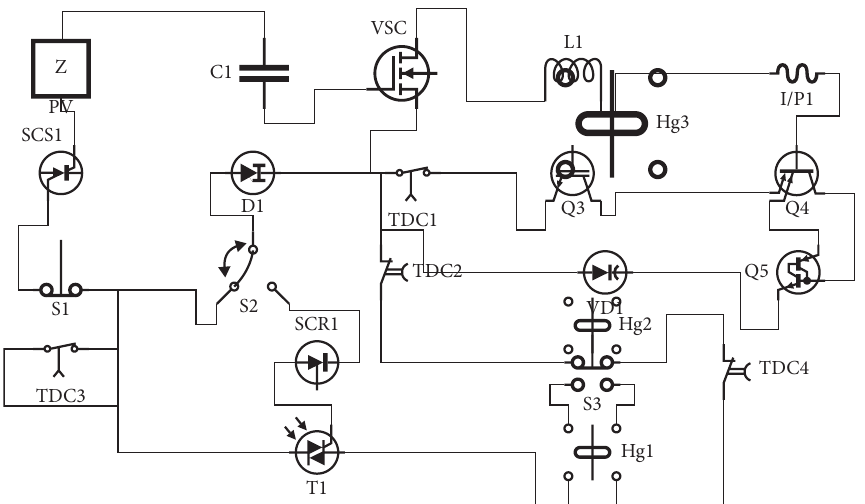
Figure 5: Logical flowchart of incoming goods management module.